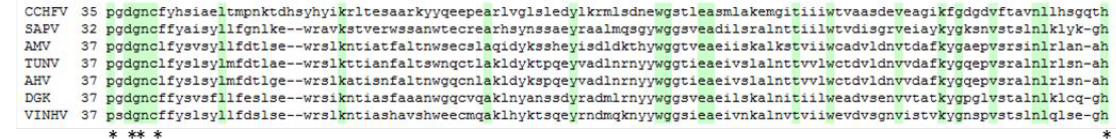
Figure 2. Ovarian tumour (OTU)-like domain on VINHV L protein. Amino acid sequence alignment of a fragment of the L protein of VINHV and other DGK group viruses depicting a predicted (OTU)-like protease domain close to the N-terminal region. Amino acids that constitute the domain are marked with * below the sequence. Amino acids conserved between the DGK group viruses and CCHFV are shaded green.